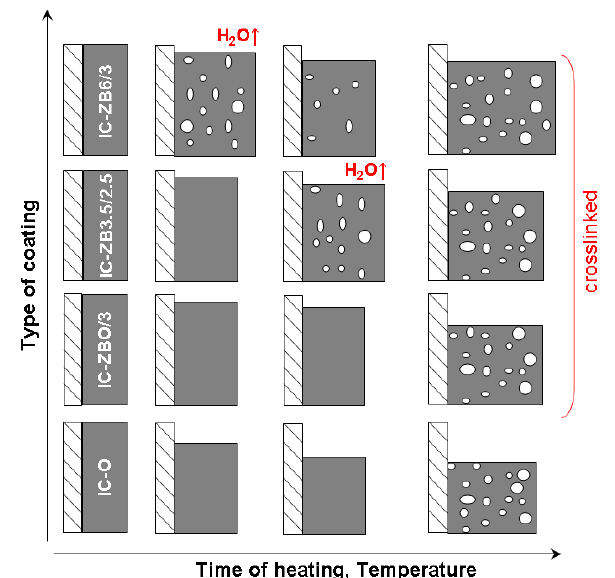
Figure 9. A schematic illustration of foaming process of the selected intumescent coatings with various zinc borates.